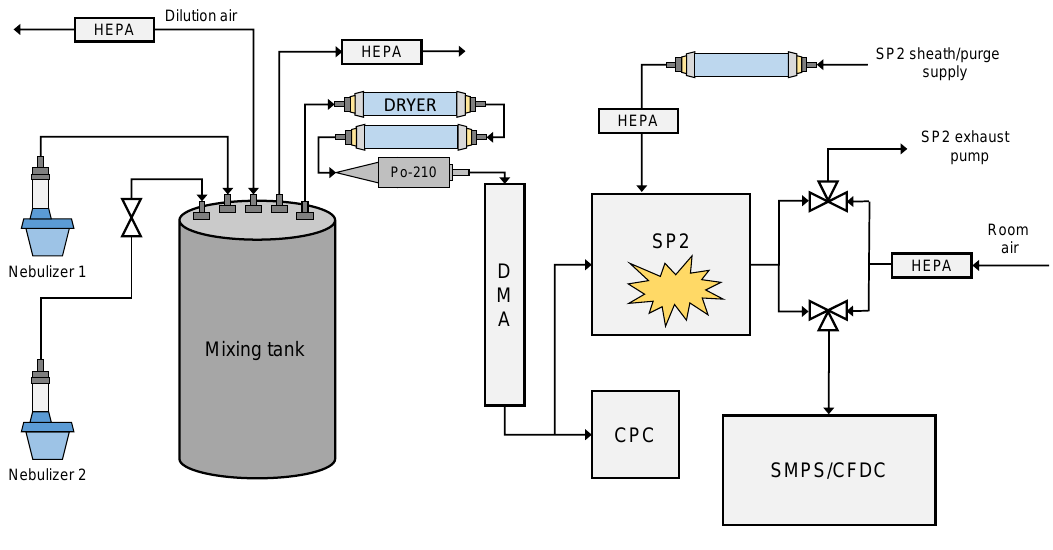
Figure 1. The experimental setup for unmixed, internal mixing, and external mixing studies with the SP2–SMPS or